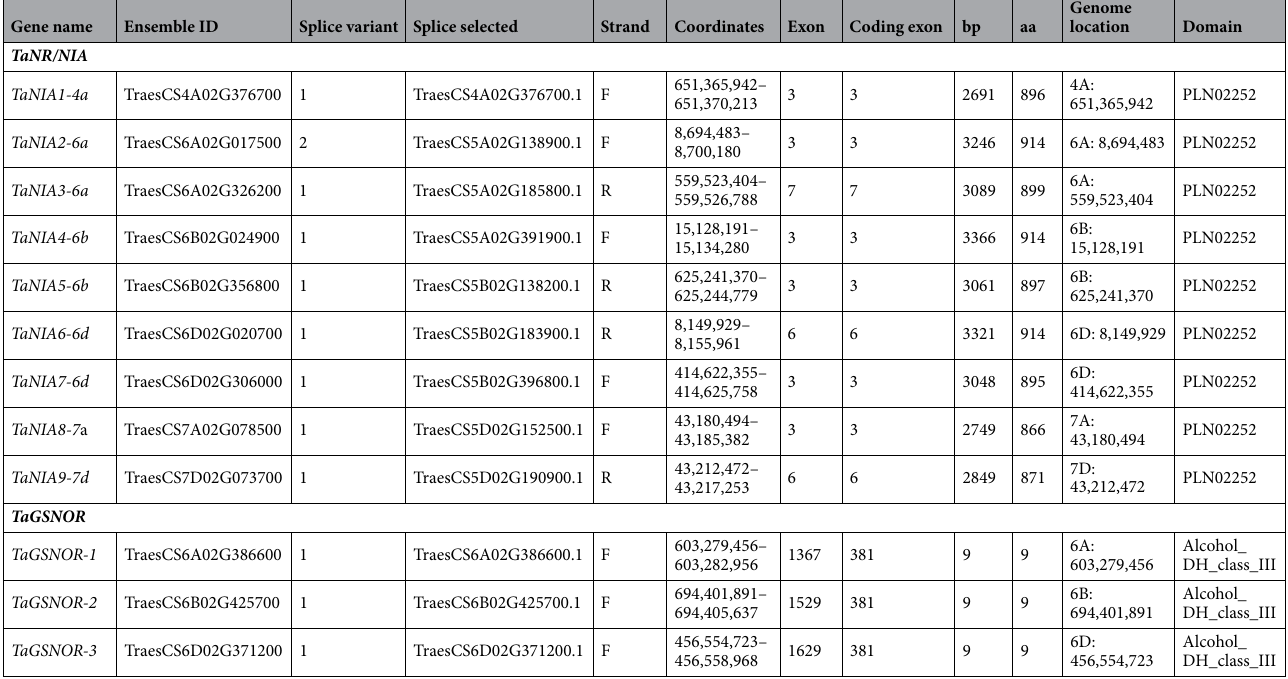
Table 1. Details of TaNIA and TaGSNOR genes with their gene ID, length, chromosome location, coordinates, and splice variants. PLN02252; nitrate reductase [NADPH], and Alcohol_DH_class_III; S-(hydroxymethyl) glutathione dehydrogenase.